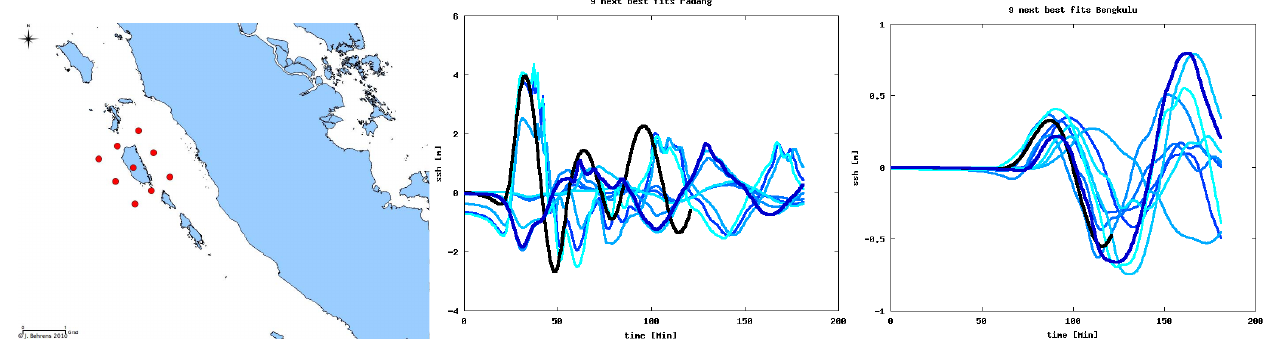
Fig. 10. Benchmark experiment with given seismic parameters and arrival times (see Fig. 9 for description of the three